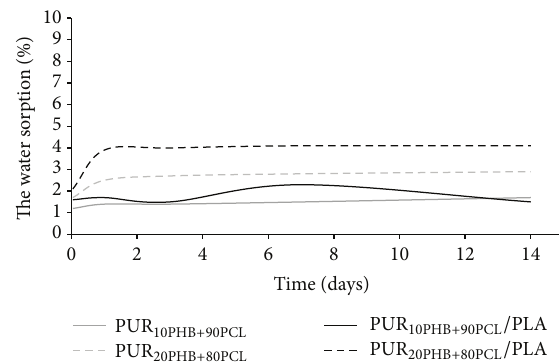
Figure2:Changesofwatersorptionbypolyesterurethanesandtheir blends with PLA during incubation in deionized water ( ± SD in range